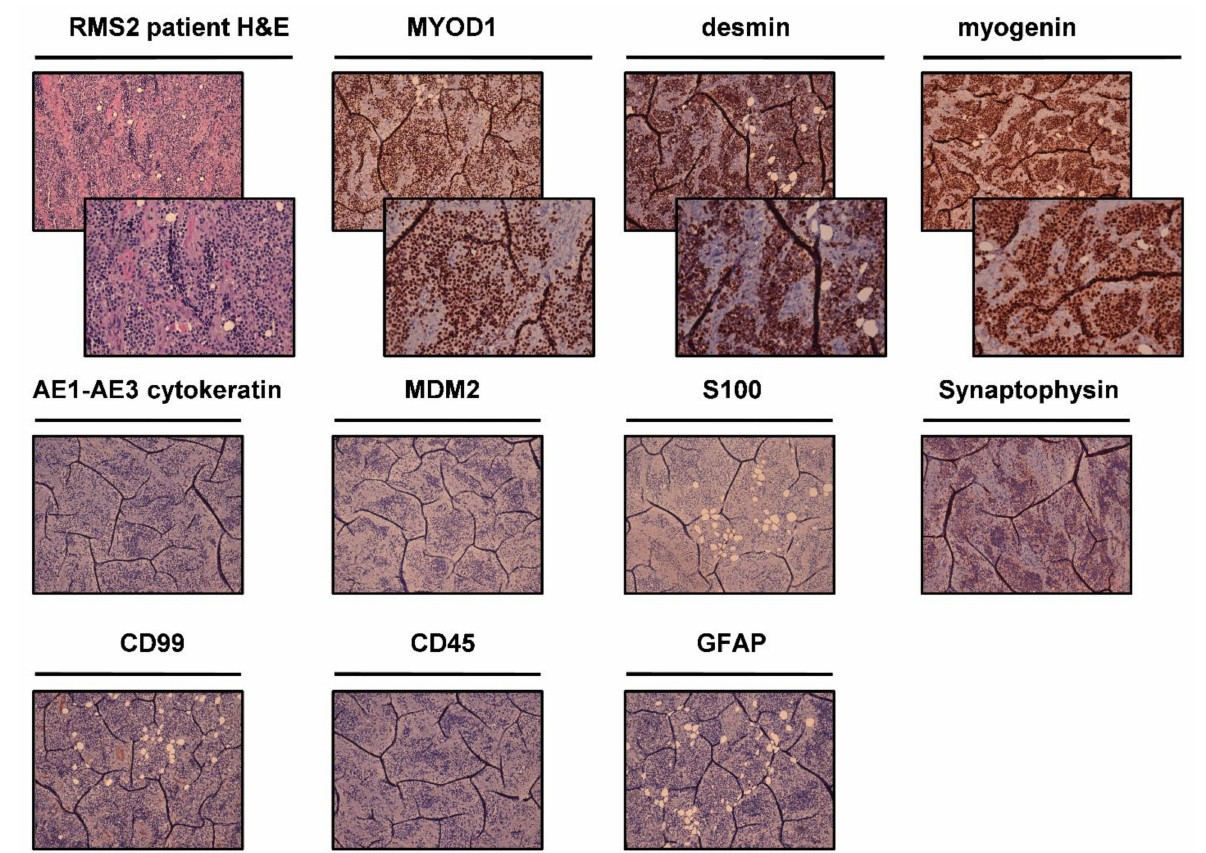
Figure 3. RMS2 patient histological and immunohistochemical analyses. H&E of the patient surgically resected tumor specimen. IHC analysis was performed on patient surgically resected tumor specimen for the following markers: MYOD-1, desmin, myogenin, AE1-AE4 cytokeratin, MDM2, S100, synaptophysin, CD99, CD45, and GFAP. For each marker, upper panels represent 10 × magnification, and lower panels represent magnification 20 × (negative markers are represented with only 10 ×